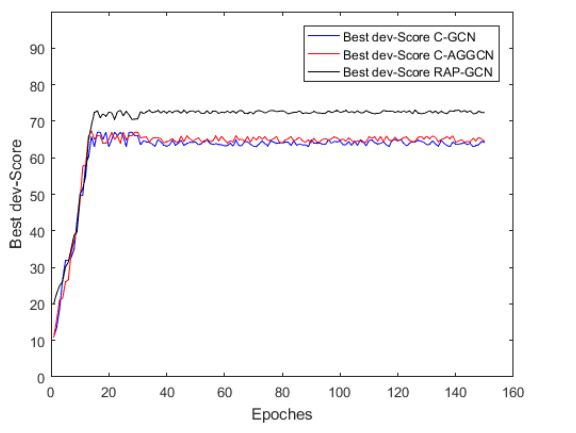
Figure 13. Epoch-F1 (Val).